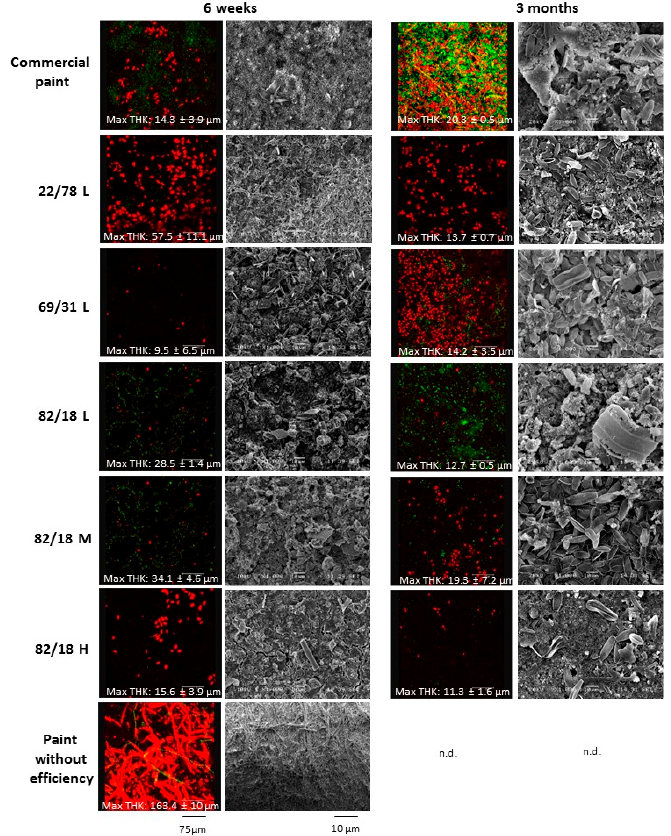
Figure 1. Microfouling development onto paints immersed in Ocean Atlanti.